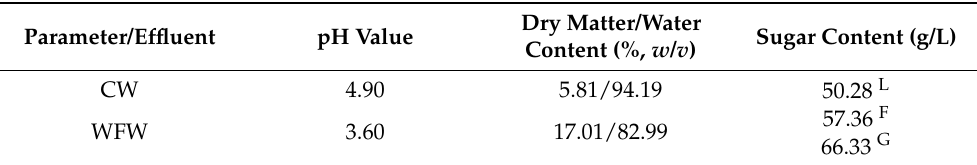
Table 1. Quality parameters of the food industry effluents used as media basis for production of microbial biocontrol